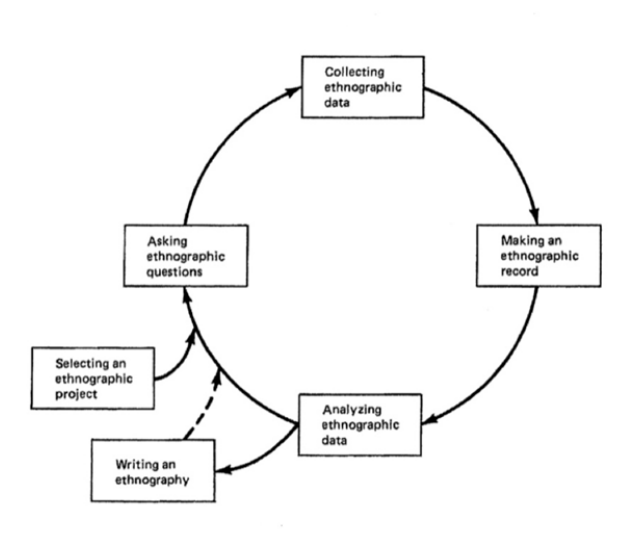
Figure 1. The ethnographic research cycle adapted from